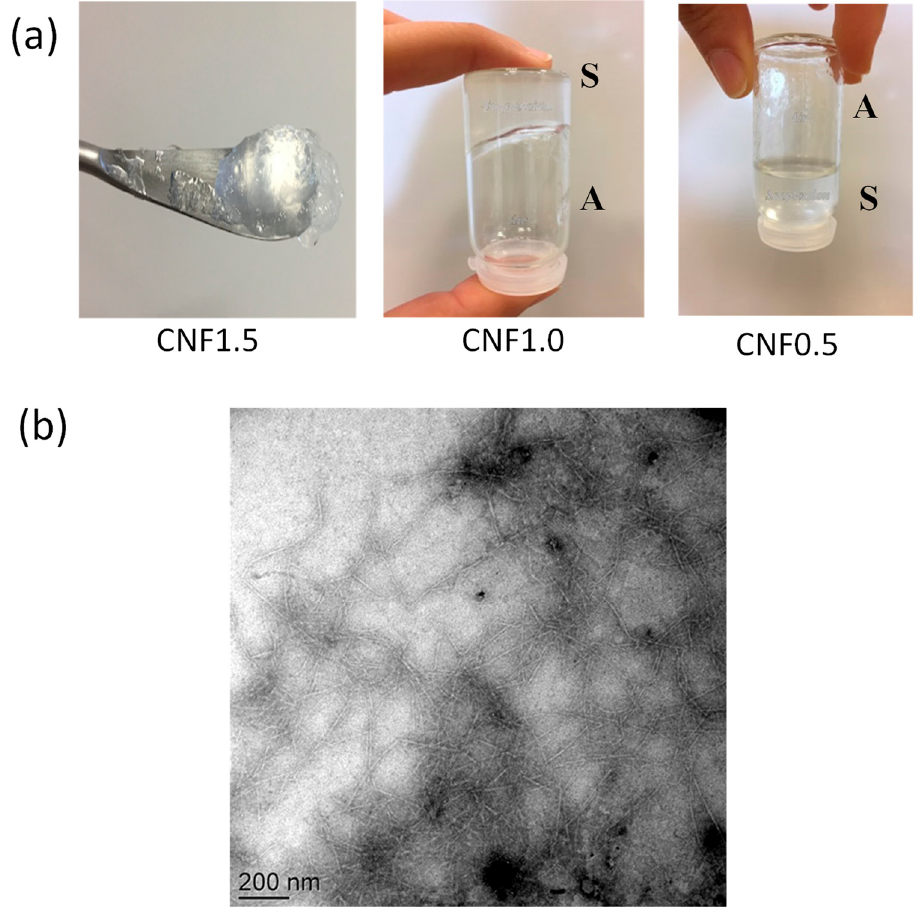
Figure 3. ( a ) Photos showing the appearance and flow of viscous suspensions containing TEMPO- oxidized cellulose nanofibers (CNF) at different concentrations of 1.5, 1.0, and 0.5 % w/w. S: Solu- tion/suspension, A: air. ( b ) TEM micrograph of TEMPO-oxidized cellulose nanofibers.